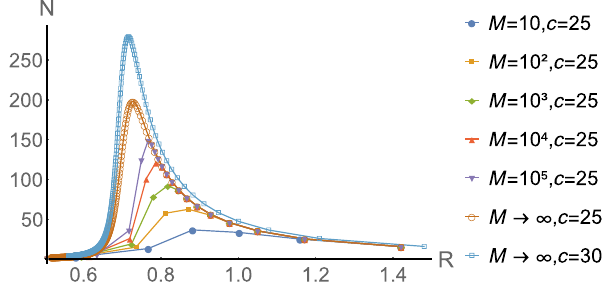
FIG. 5. The trade-off between clock accuracy N and resolution R for clockworks of various complexities, where R is increased by decreasing d . For finite horizontal extensions M , we show this behavior for a fixed photon field coupling c ¼ 25 , where ½ c (cid:2) ¼ s − 1 . Increasing M allows for higher maximal accuracy, and, thus, the orange line represents an upper bound of the accuracy for a given resolution for all clocks with c ¼ 25 . For M → ∞ , we see that increasing c increases the potentially achievable combinations accuracy and resolution. We choose g ¼ E in all C